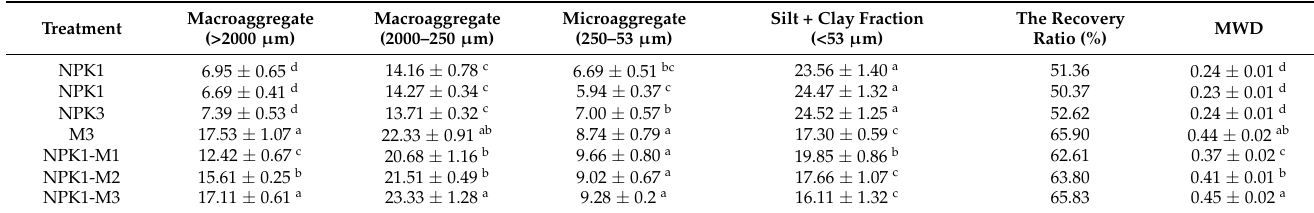
Table 2. Effect of different fertilization types on the distribution and stability of aggregates.